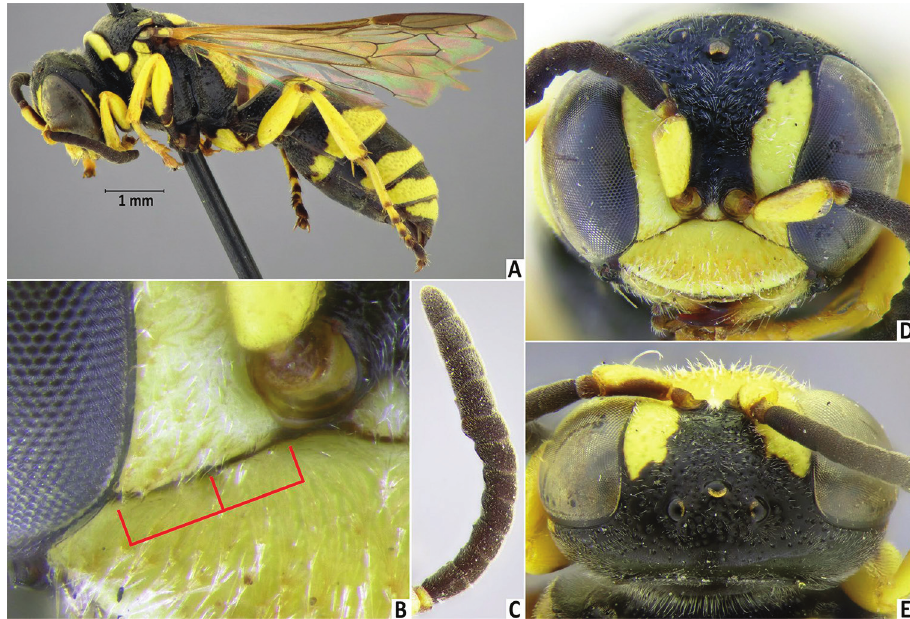
Figure 4. Hoplisoides leleji Mokrousov, sp. nov., male, paratype: A habitus, lateral view B tentorial pit and adjacent area, frontal view C antenna, dorsal view D head, frontal view E head, dorsal